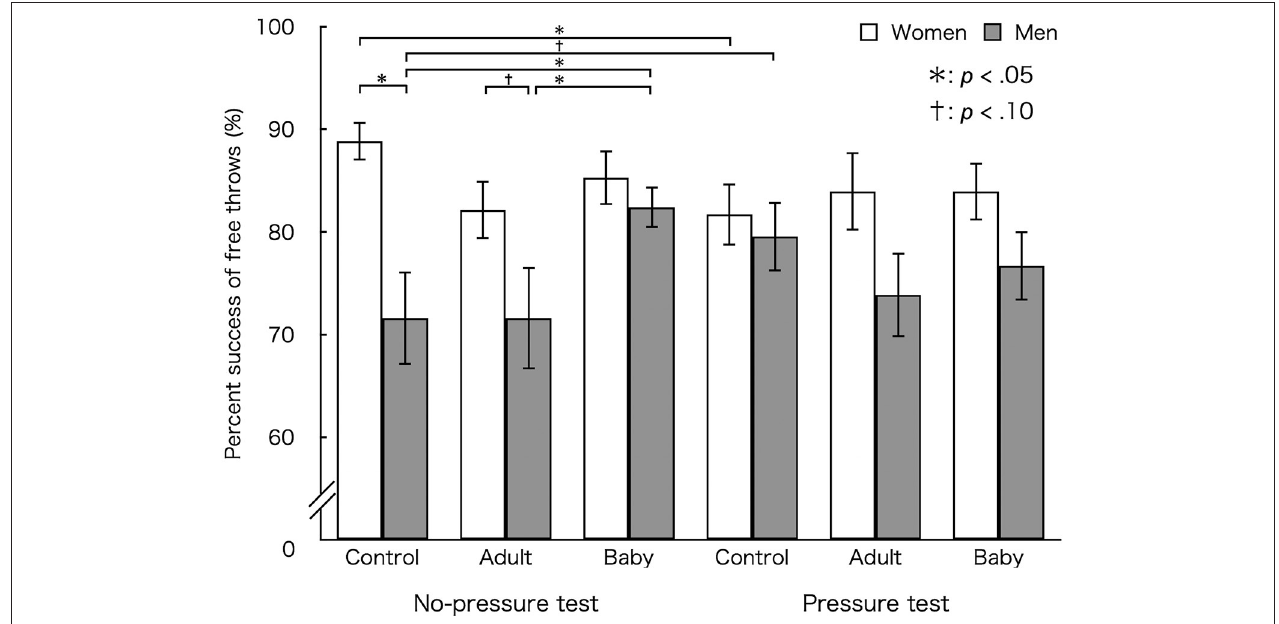
FIGURE 1 | Mean percent success in each test. Baby, viewing pictures of baby animals; Adult, viewing pictures of adult animals; Control, viewing no pictures. Error bars indicate standard error of the mean